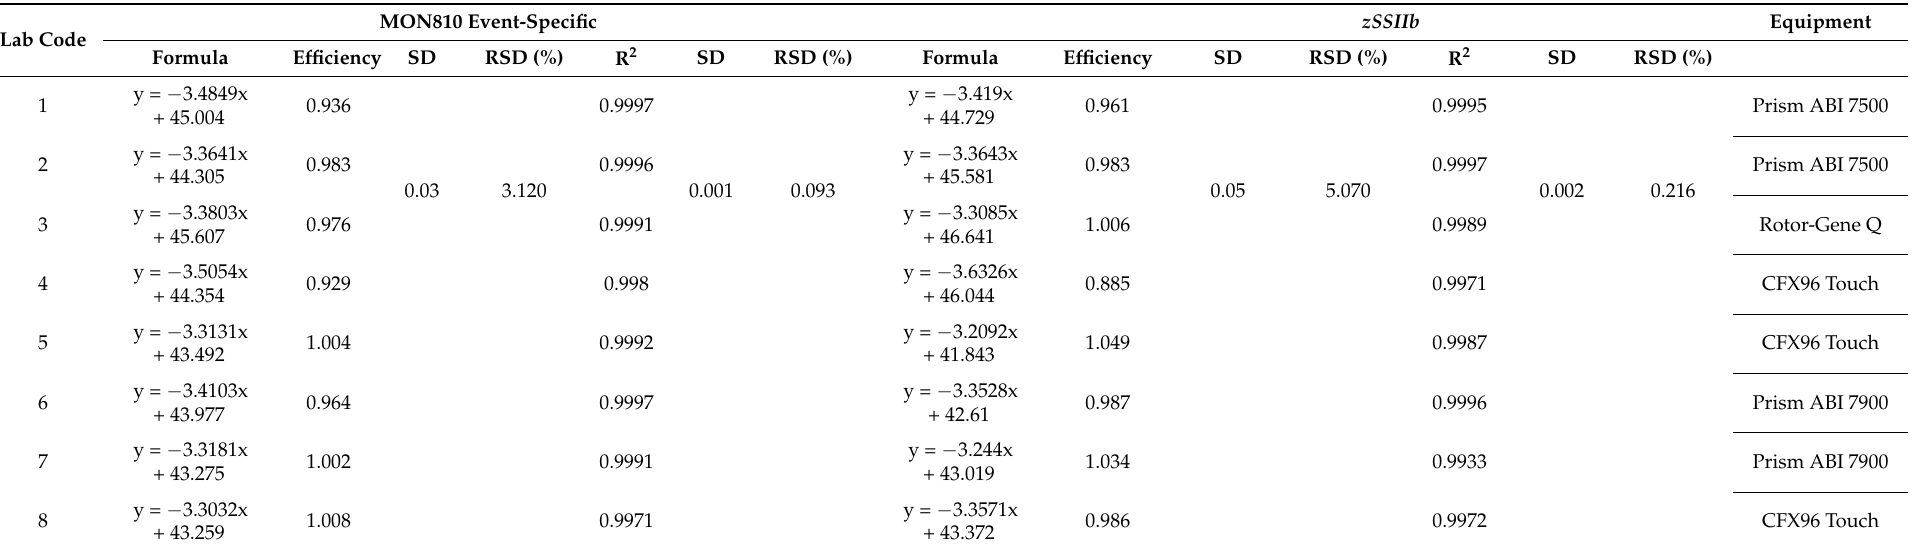
Table 1. Formula, PCR efficiency, and linearity (R 2 ) of each qPCR assay standard curve from eight